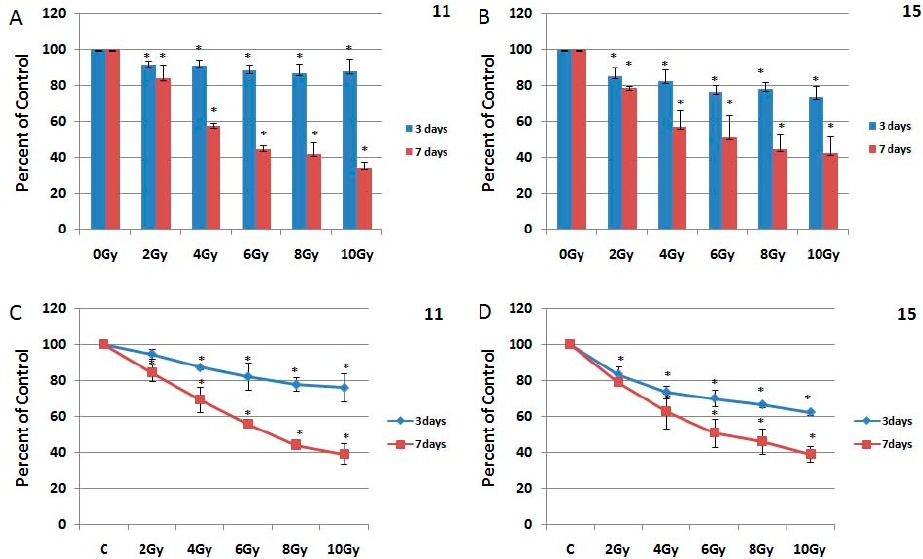
Figure 4. The effect of ionizing radiation on HGG cells. The 11 HGG ( A , C ) and 15 HGG ( B , D ) cells were seeded in 96-well culture plates or in 12-well culture plates and irradiated with 2 Gy, 4 Gy, 6 Gy, 8 Gy, 10 Gy and incubated for three or seven days. The cell viability was, then, determined by MTT assay and by Trypan Blue Exclusion Test. All results show the mean of three independent experiments ± SD, * p < 0.05 vs. untreated